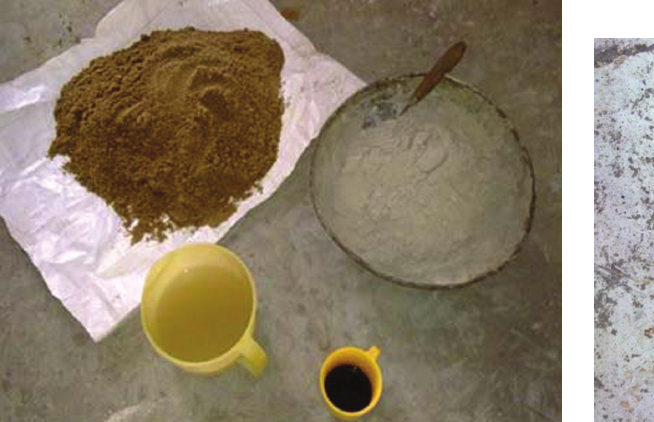
Figure 2 Chicken